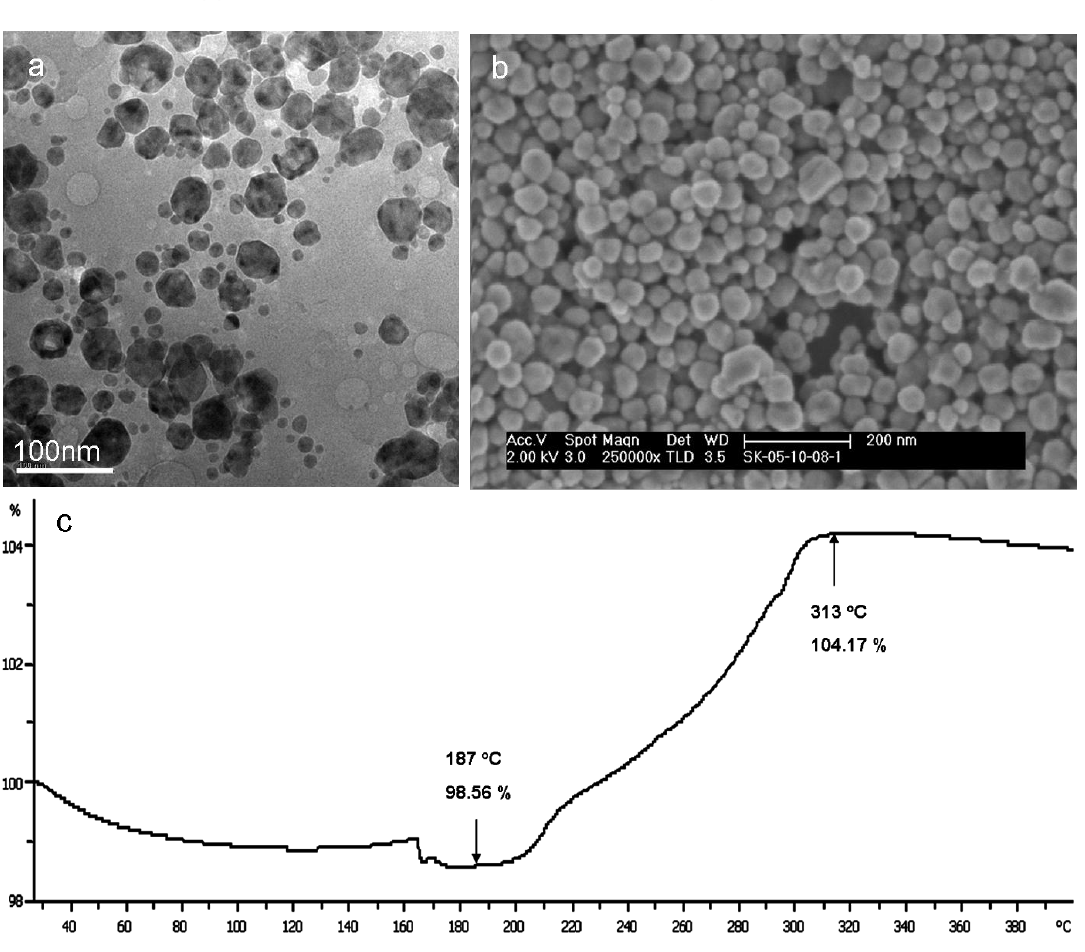
Figure 5. ( a ) TEM and ( b ) SEM images of the obtained copper-silver core-shell NPs; ( c ) TGA of the copper-silver core-shell NPs under air